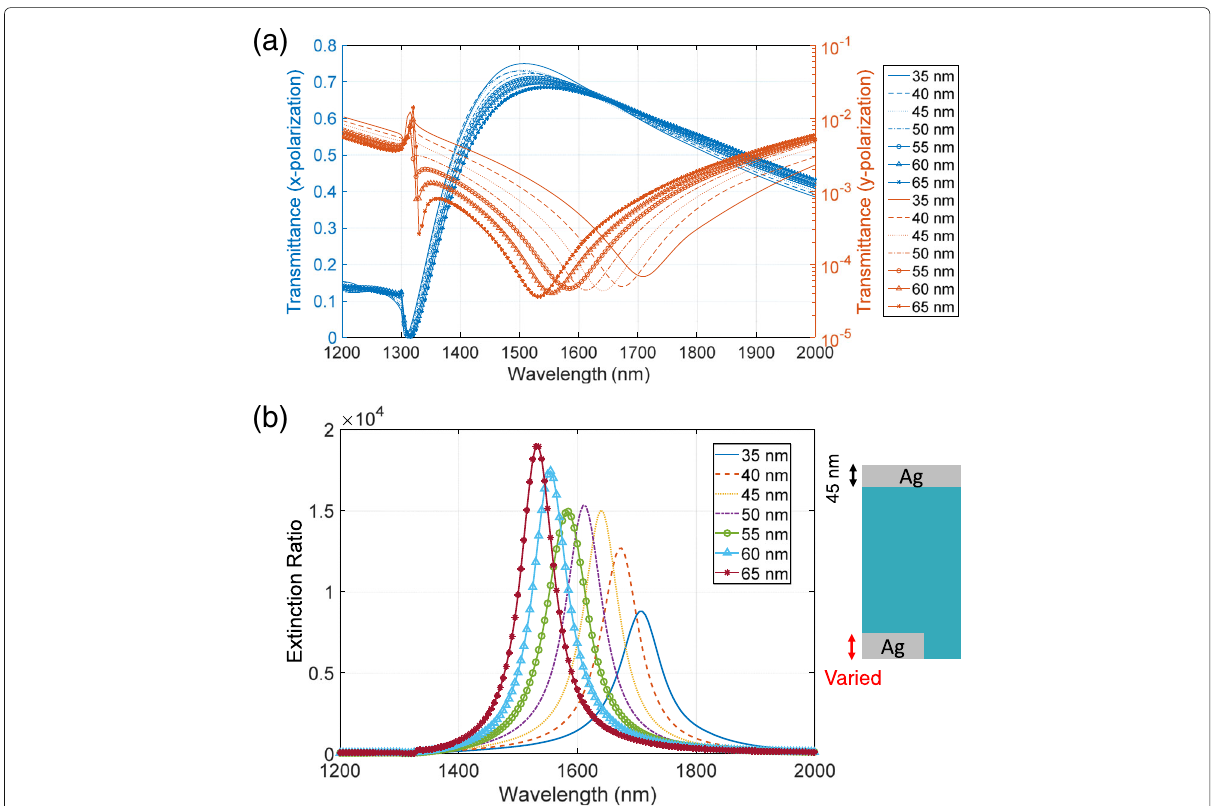
Fig. 14 a Transmittance and b extinction ratio spectra when the complementary metallic layers have different thicknesses. The thickness of the top metallic layer is fixed to be 45 nm, while that of the bottom layer is varied from 35 to 65 nm with a step of 5 nm (see the inset in b